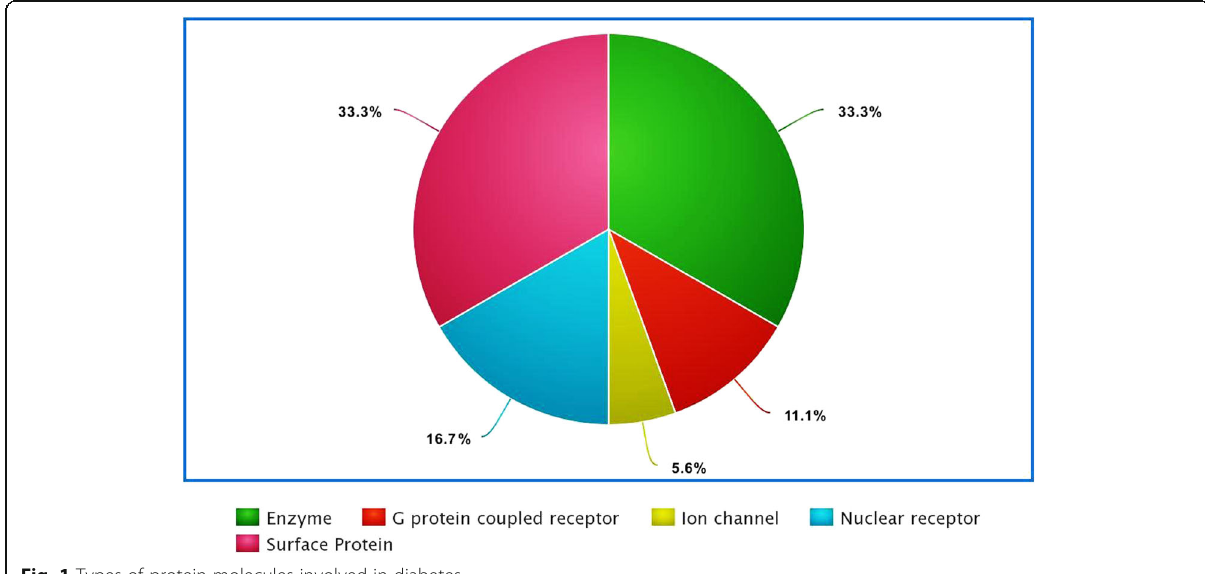
Fig. 1 Types of protein molecules involved in diabetes